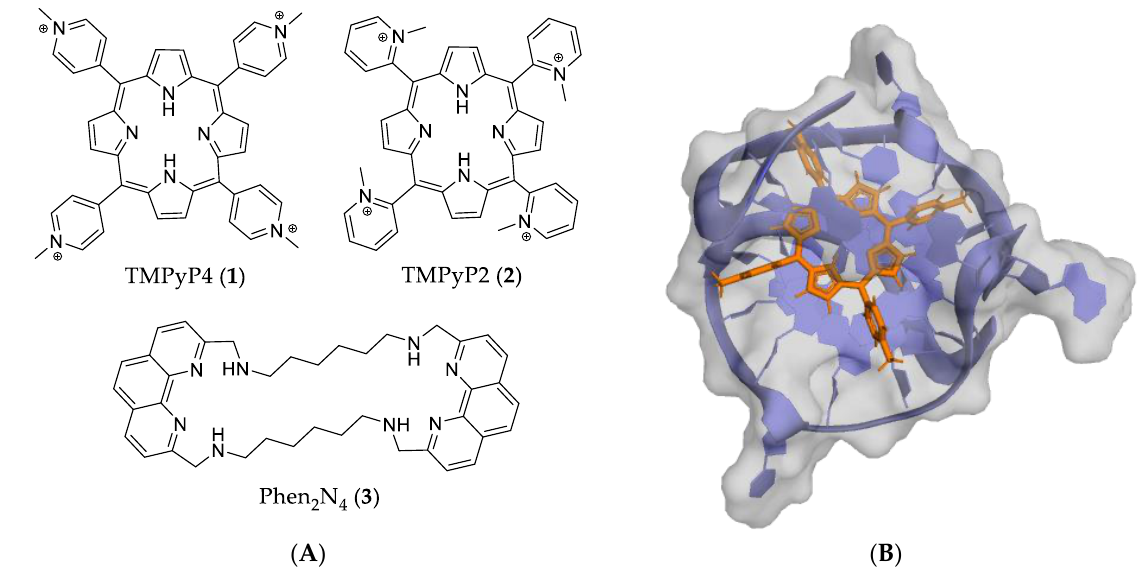
Figure 4. ( A ) Structures of porphyrin macrocycles 1 and 2 and macrocycle 3 . ( B ) PDB 2A5R repre- senting porphyrin 1 in complex with a two-quartet c-MYC G4.